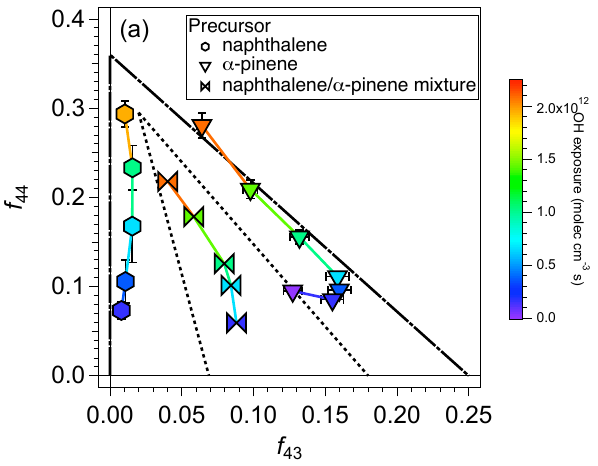
Fig. 4. f 44 shown as a function of f 43 for SOA generated in the PAM reactor from a mixture of naphthalene and α -pinene. f 43 and f 44 data for SOA generated seperately from naphthalene and α -pinene are replotted from Fig. 2. Error bars represent ± 1 σ in measurements. Dashed lines indicate range of ambient f 44 and f 43 measurements, while dashed-and-dotted lines indicate range of lab- oratory PAM reactor